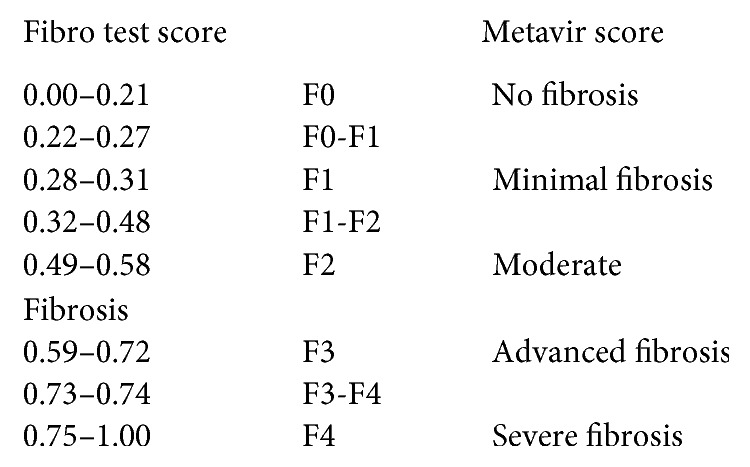
Metavir stage guide.